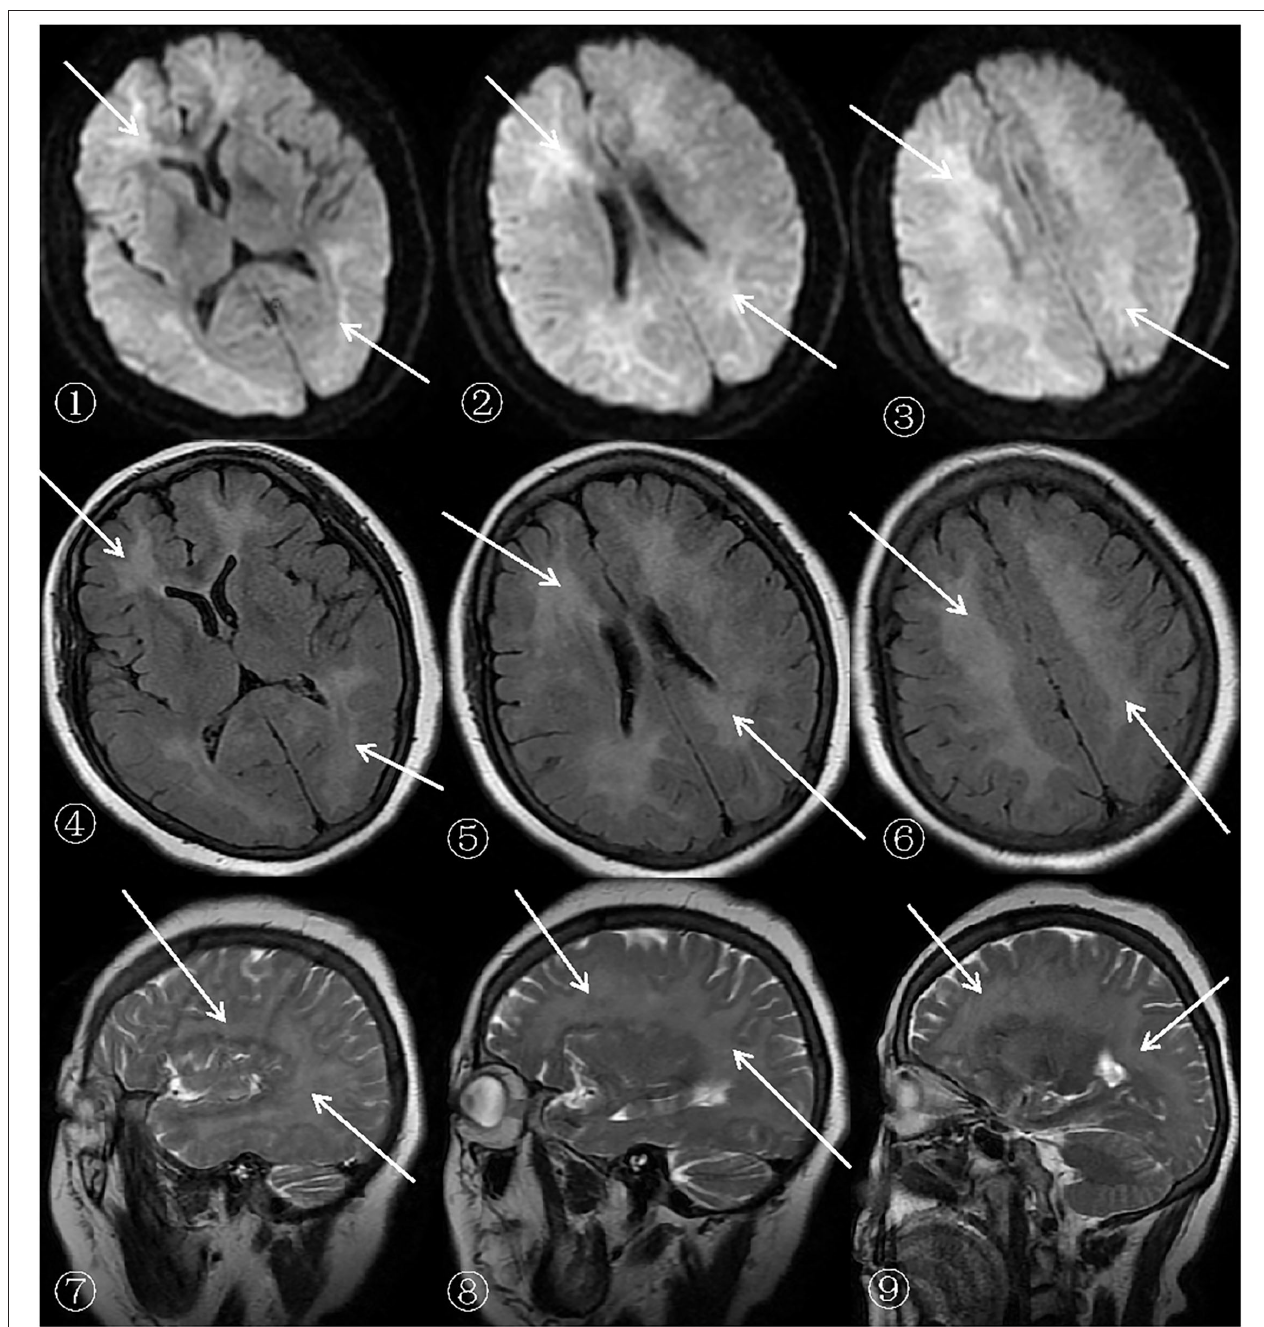
FIGURE 2 | MRI (SIEMENSAGFWB, skyra 3.0 tesla) images of the patient’s brain.